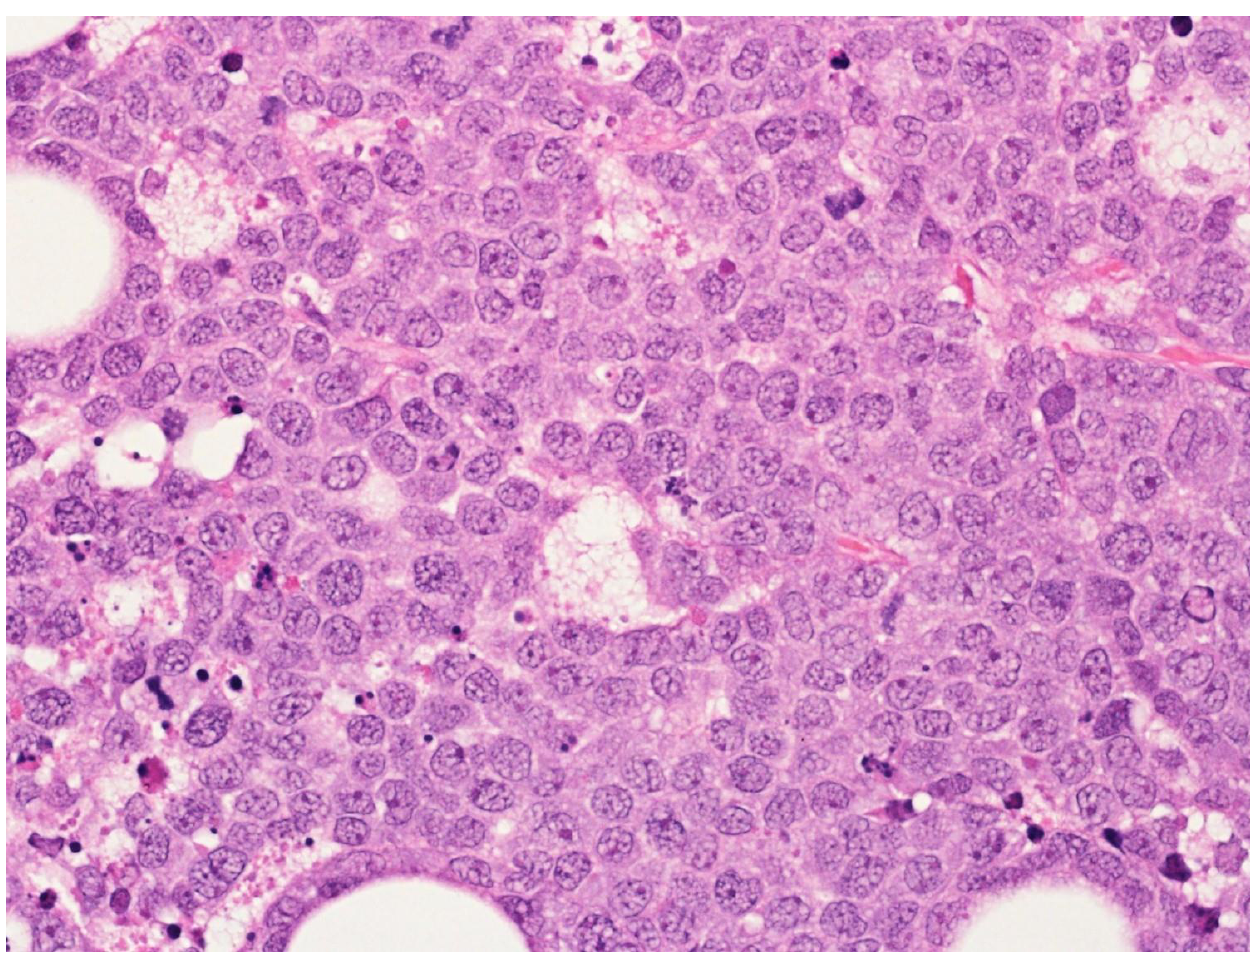
Figure 15. High-grade B-cell lymphoma, NOS (H&E ×400). The tumor cells are small to medium- sized with scant cytoplasm and roundish nuclei. No apparent starry-sky pattern is seen. This tumor was negative for MYC , BCL2 , and BCL6 rearrangements and also negative for 11q aberrations.